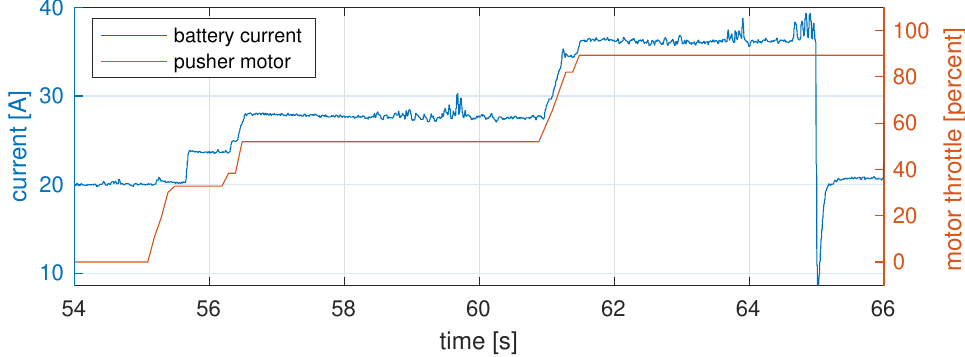
Figure 28. Telemetry log from an in-flight experiment: a close-up on pitch instability observed in quadcopter mode when the pusher motor increased the drone’s speed in a horizontal flight.